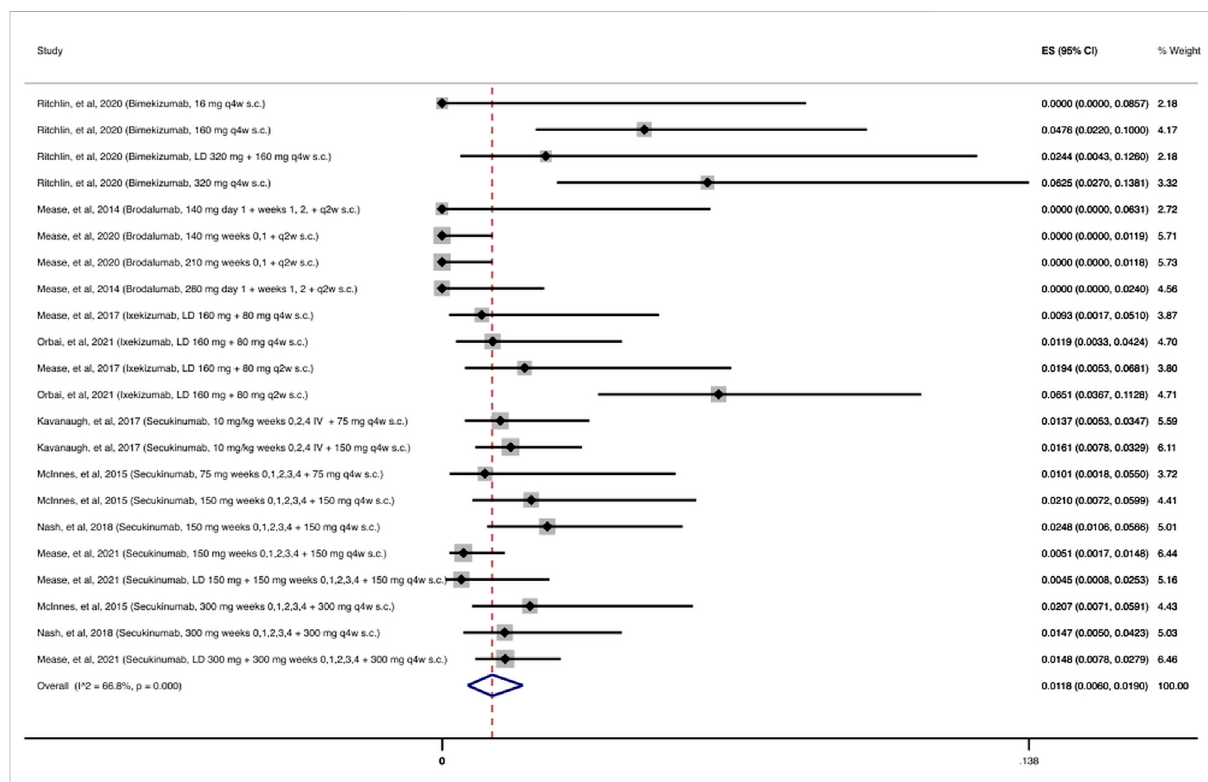
FIGURE 3 Opportunisticinfectionscumulativeincidenceforanti-IL-17duringRCTsandtheirextensionperiods.Individualandcombinedestimatesofthe cumulative incidence of opportunistic infections for patients treated with anti-IL-17 with 95% con fi dence intervals. ES: Effect Size (Cumulative